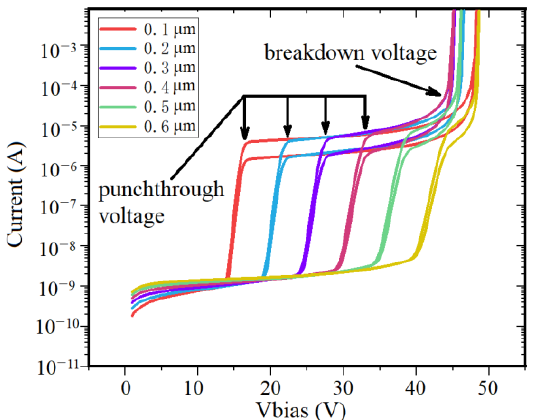
Figure 6. I-V curve of the device with different multiplication thickness.